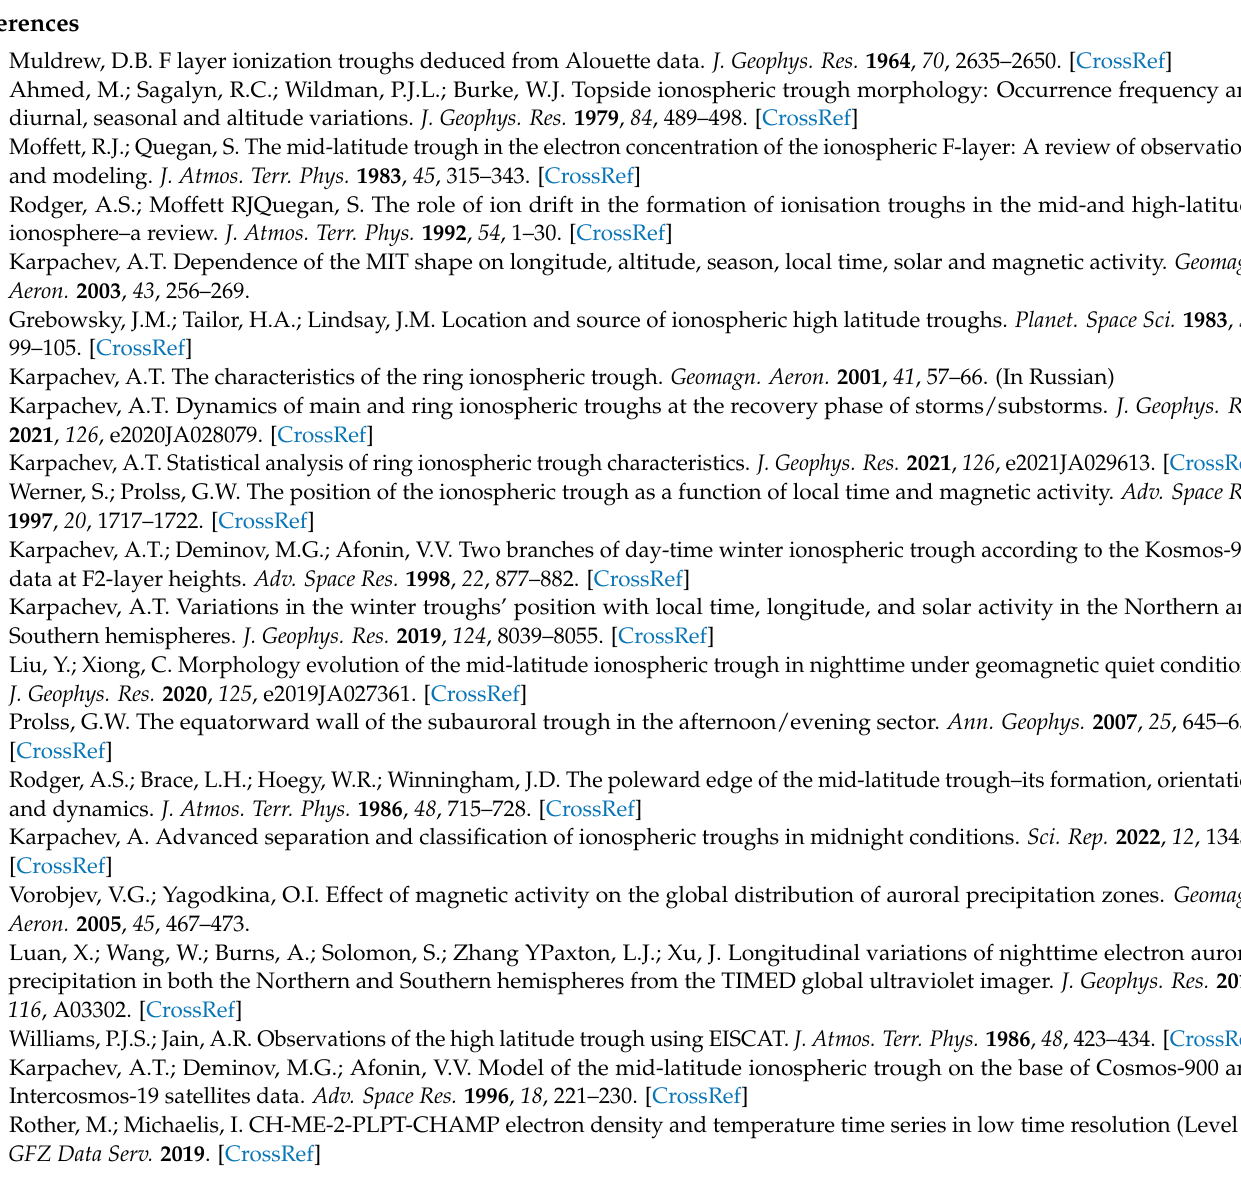
Figure S2: Longitudinal variations in the averaged auroral precipitation energy flux at 21–03 MLT under Kp = 2 for the June solstice (Jun.) in southern hemisphere